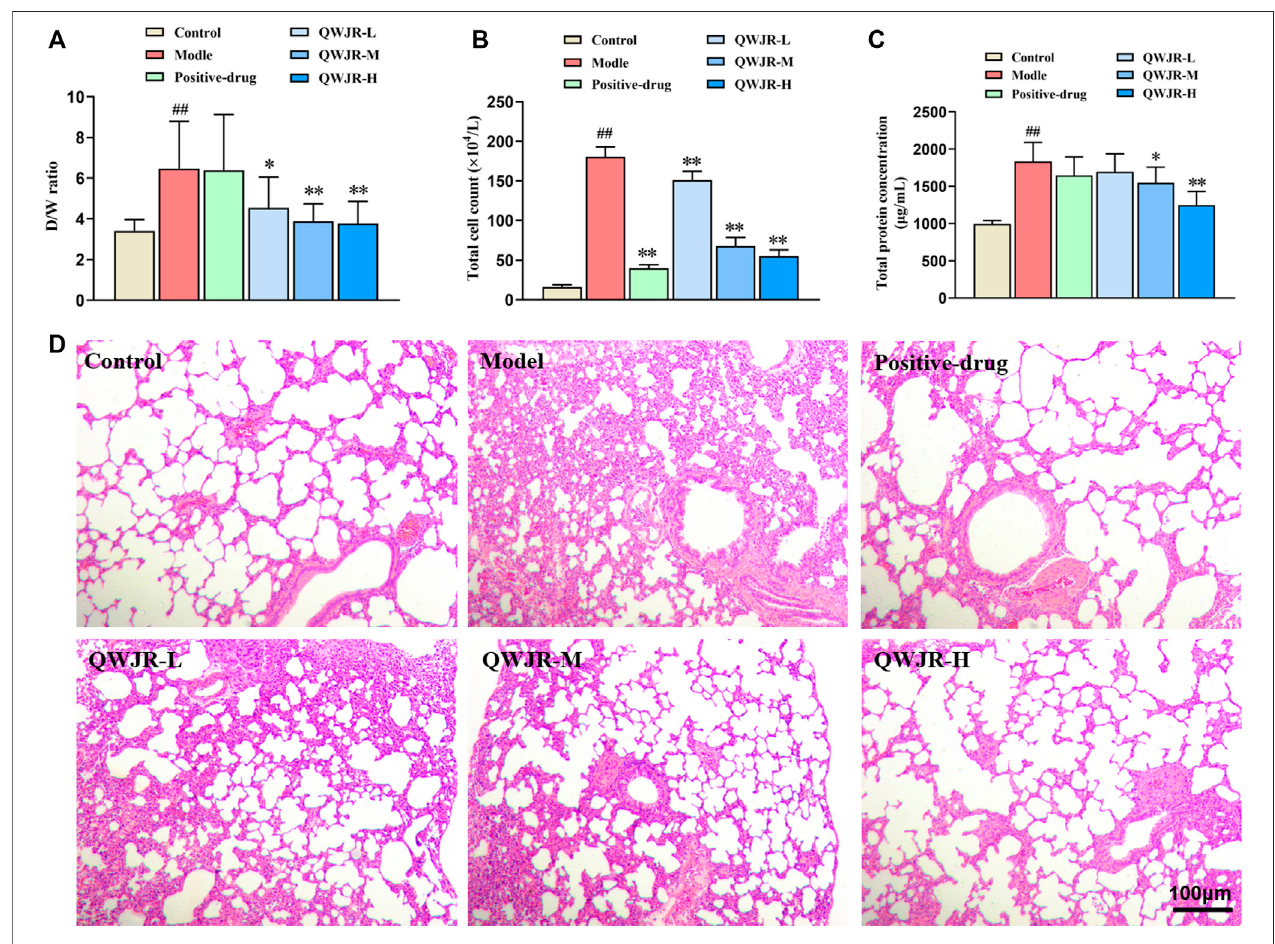
FIGURE 2 | Therapeutic effects of QWJR on poly (I:C)-induced viral pneumonia rats. (A) The W/D ratio was decreased after QWJR treatment. (B) The total cell count was decreased after positive-drug and QWJR treatment. (C) The total protein concentration was decreased after QWJR treatment. (D) After positive-drug and QWJR intervention, the histopathological changes in the rat lungs were reduced (200×). Control, model, positive-drug, QWJR-L, QWJR-M, and QWJR-H ( n = 10 per group) groups. Data are presented as the mean ± SD. ## : p < 0.01 as compared to the control group; *: p < 0.05 as compared to the model group; **: p < 0.01 as compared to the model